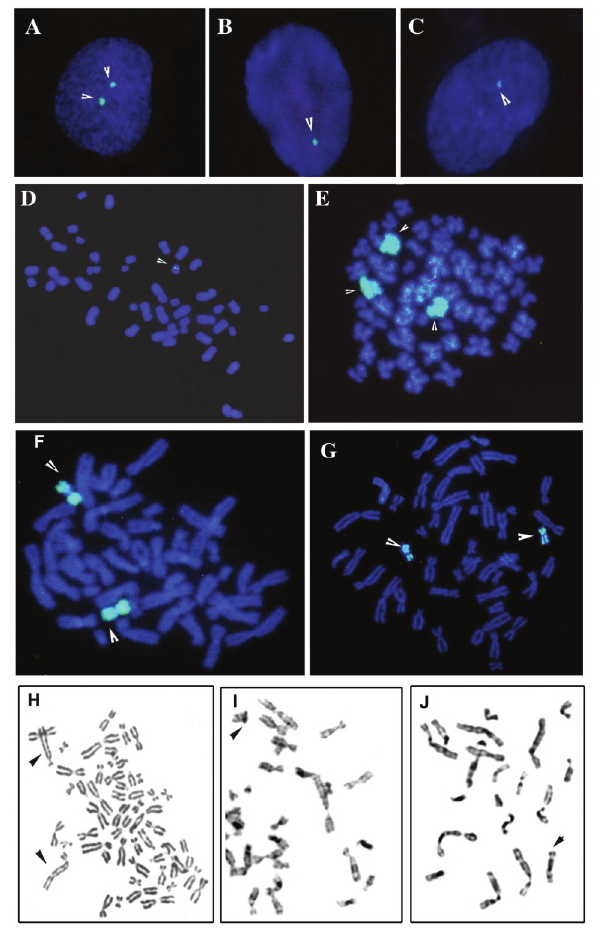
Figure 1 - FISH on metaphase chromosomes and interphase nuclei: (A - D) D17Z1 probe for chromosome 17 centromere hybridized to a control sample (A) and to tumor cases SCP122 (B), SCP135 (C), and SCP 134 (D),revealingmonosomy17(onlyonehybridizationsignal)inallthreetu- mors. (E) Trisomy of chromosome 5 observed in 1/13 metaphases after hybridization with chromosome 5 painting probe in case SCP122. (F - G) Disomyofchromosome16observedincasesSCP134andSCP167.(H-J) The marker chromosomes (arrowheads) detected by G-band analysis in cases SCP134, SCP167, and